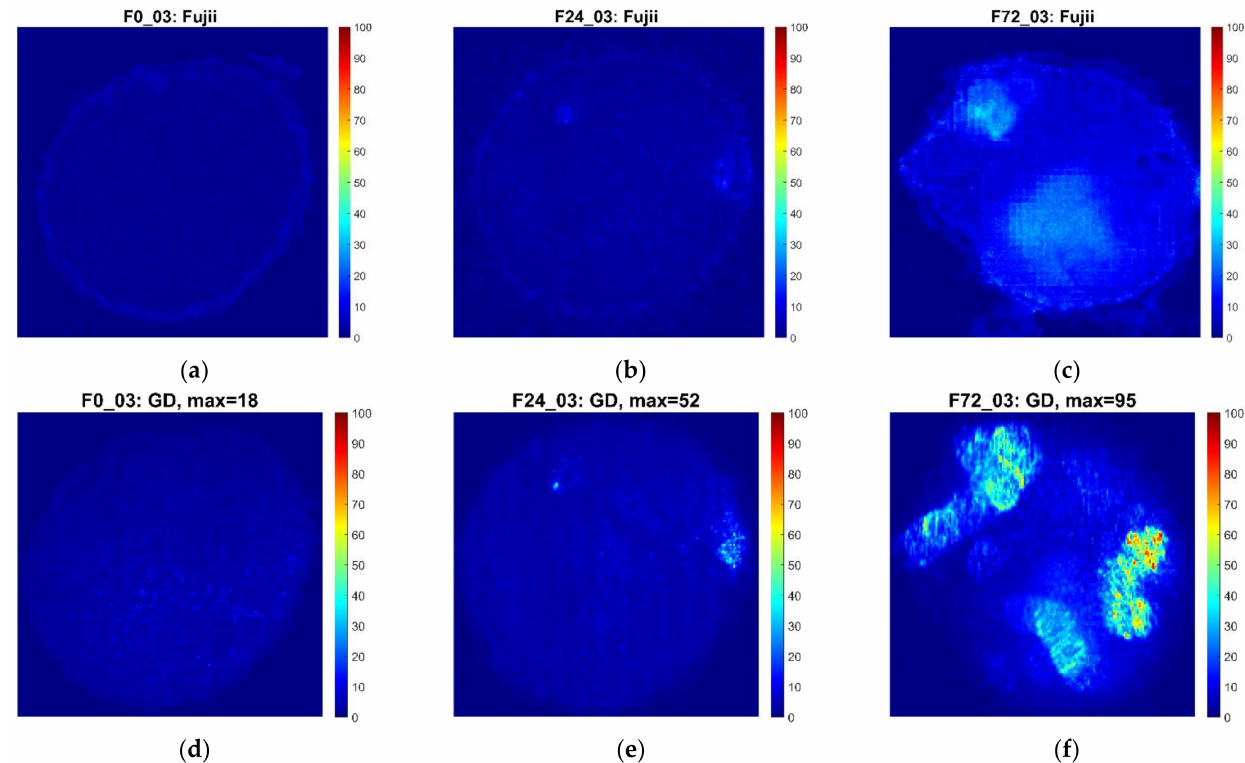
Figure 4. Example maps of biospeckle activity generated by the average difference method ( a – c ) and generalized difference method ( d – f ). Maps from left to right show stages F0 (uninfested sample), F24 (24 h after exposure), and F72 (72 h after exposure) of example fruit No. 03. Dark blue and red colours correspond to the lowest and the highest values respectively. ‘Max’ stands for the maximum value of general